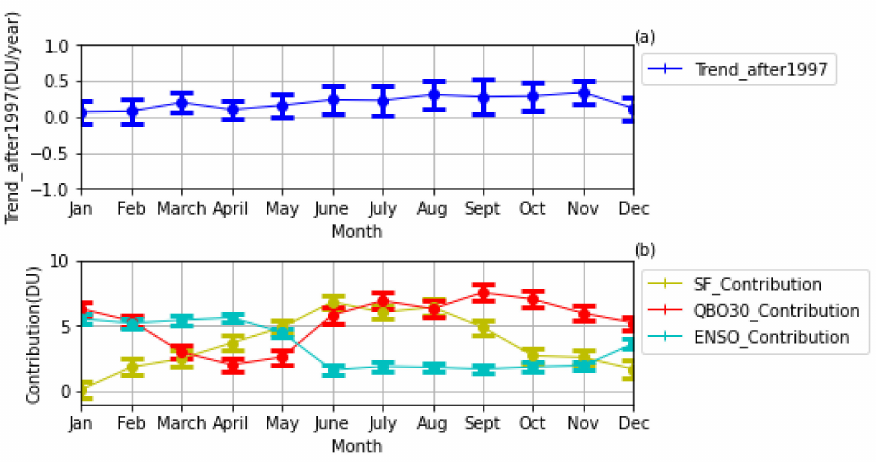
Figure 6. The trend in the variability of ozone per month (2 σ ) in Togo after 1997 ( a ), the seasonal contribution of the forcings ( b